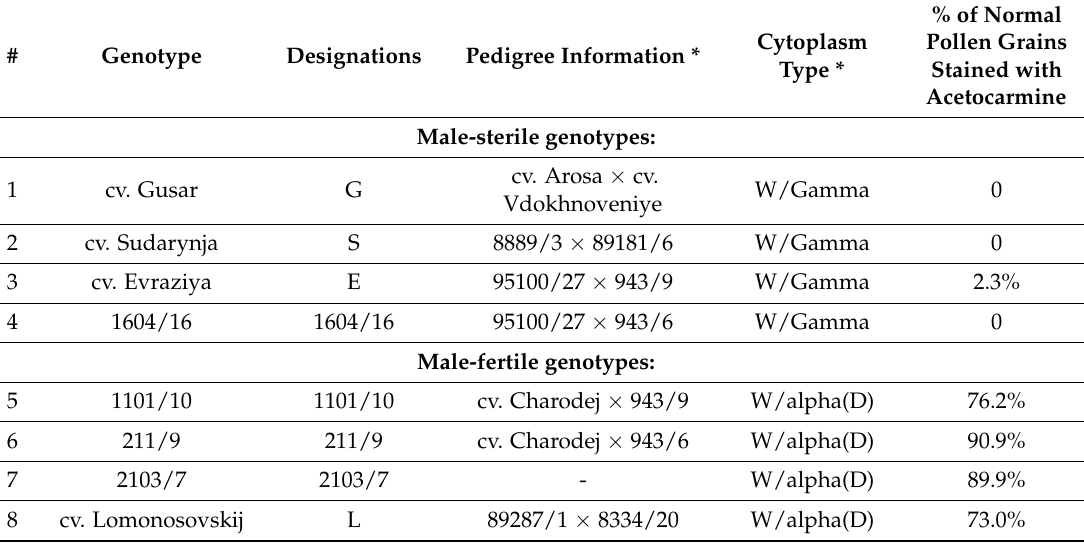
Table 1. Plant material used in the